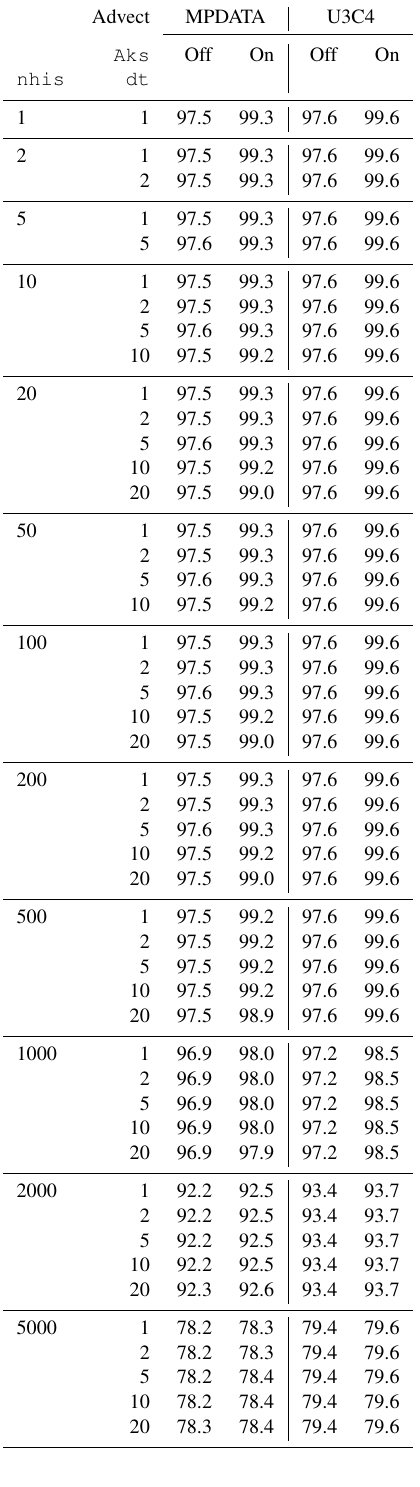
Table A1. Final skill score (percent) of offline simulations after 14d, sorted by nhis and dt values, tracer advection scheme, and if Aks is